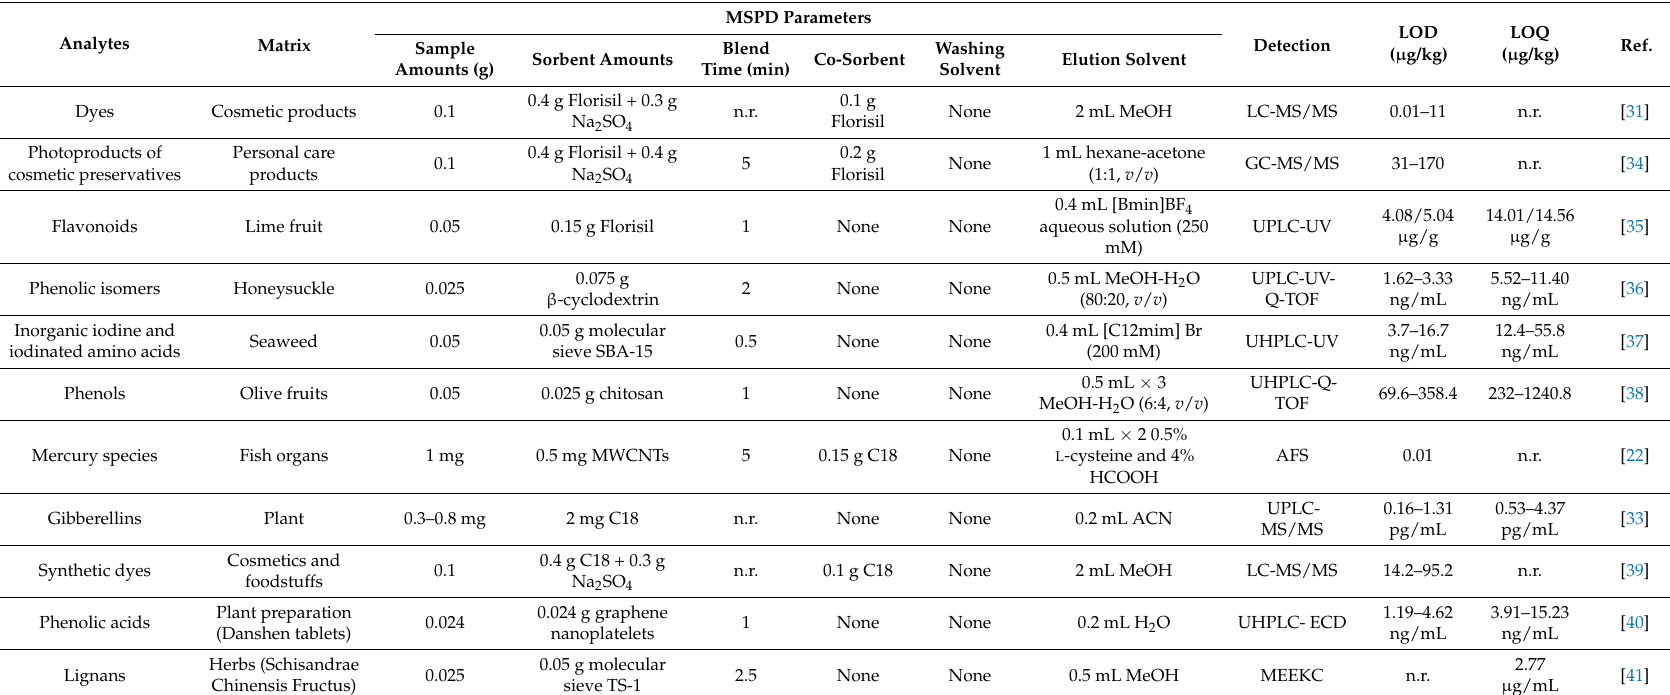
Table 2. Selected representative studies using miniaturized